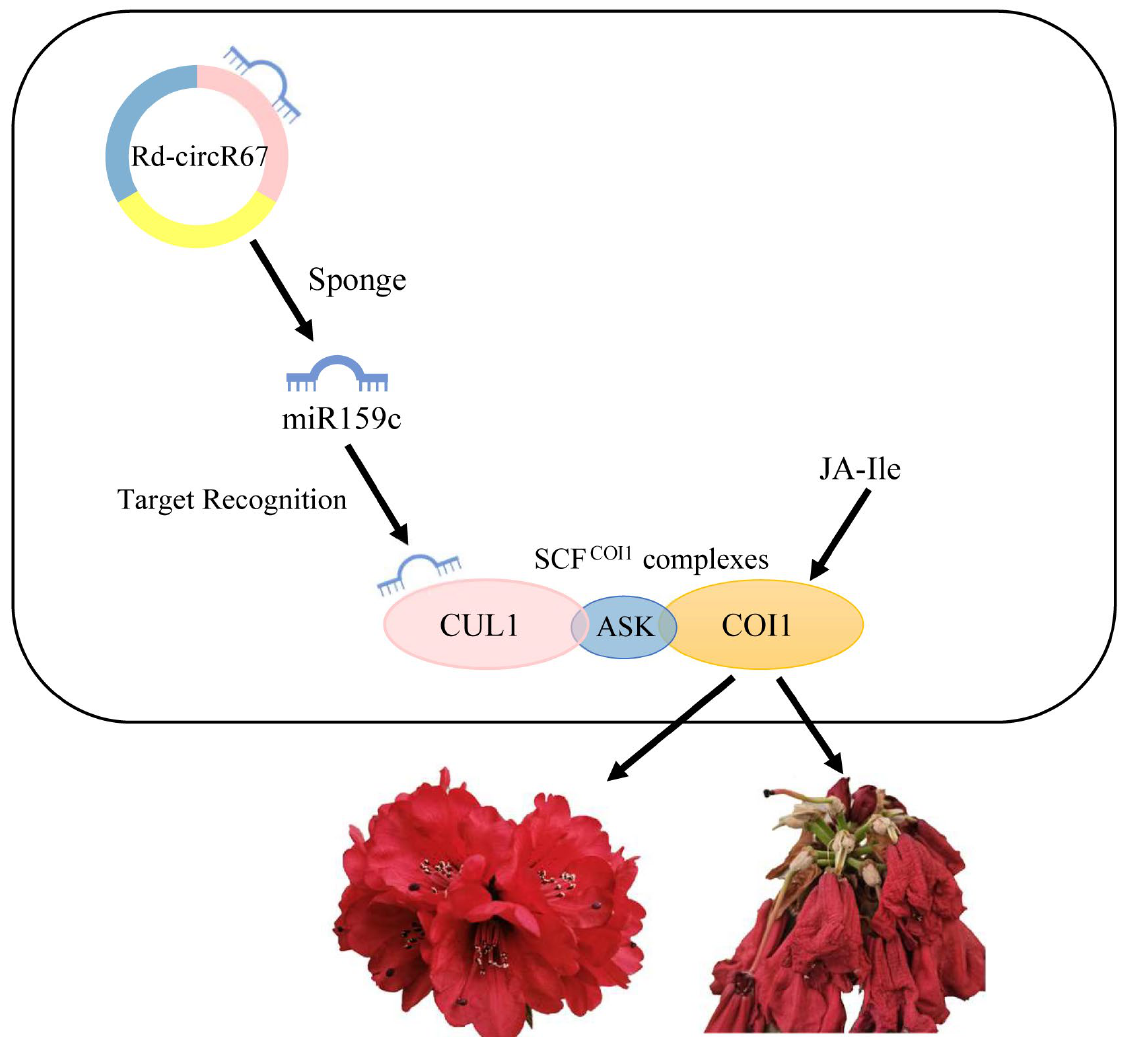
Figure 7. A proposed model for the regulatory network of cicRNA during flower development of Rhododendron floral development and senescence.